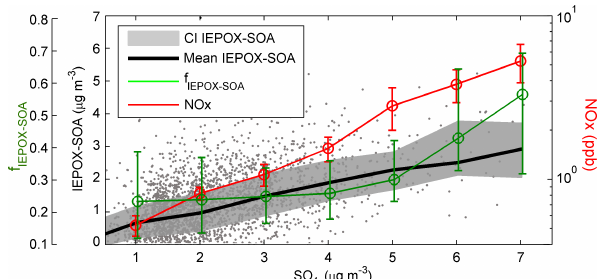
Figure 7. Scatterplot between IEPOX–SOA concentration and SO 4 . Black line and grey area represents mean and 5 and 95% confidence intervals of the mean, respectively. Red and green markers are mean NO x and f IEPOX–SOA , respectively, and range bars represent 5 and 95% confidence intervals of the mean. The data shown here include all ATR42 measurements at altitudes below